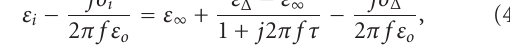
Figure 10: The simulated fidelity factor with the distance from the antenna in the presence of a human